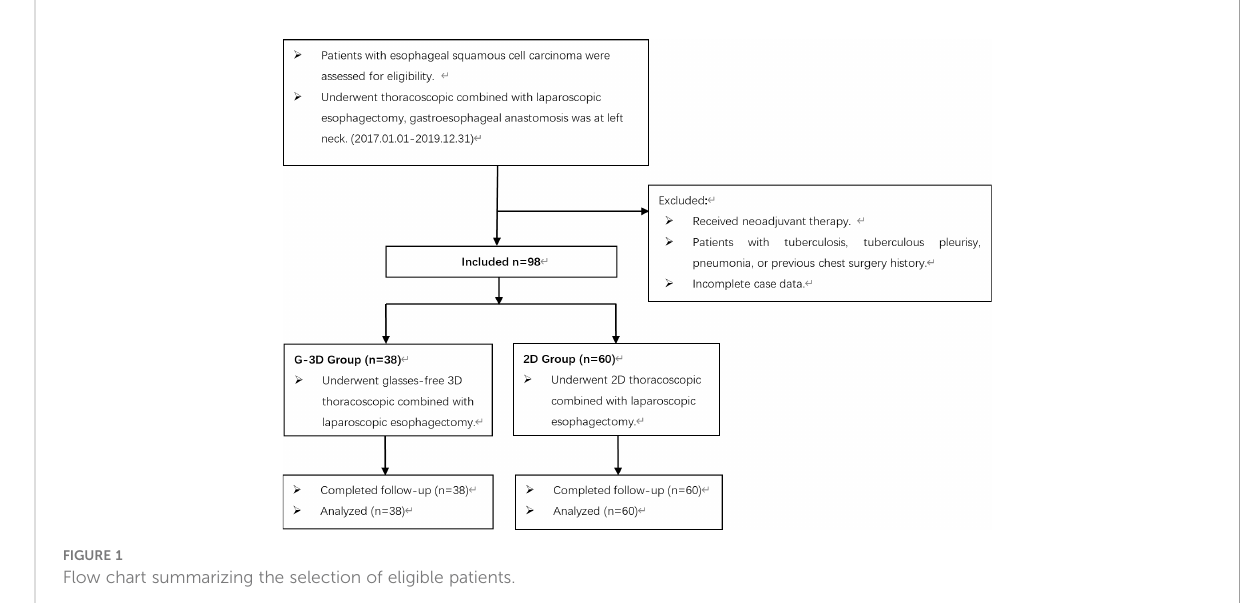
FIGURE 1 Flow chart summarizing the selection of eligible patients.